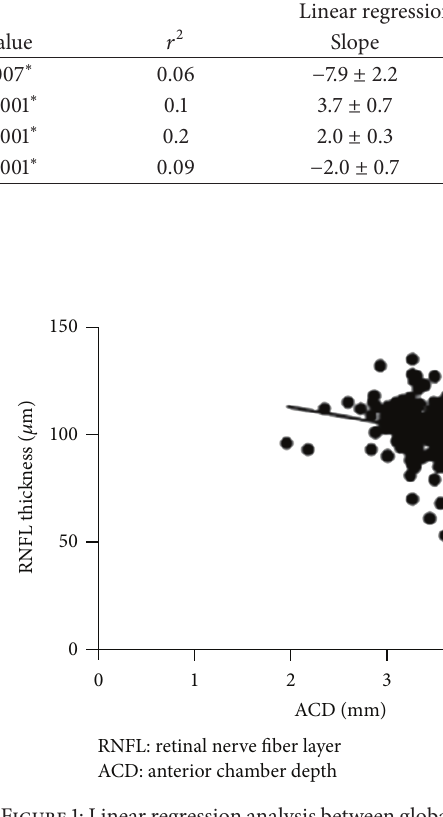
Figure 1: Linear regression analysis between global RNFL thickness and